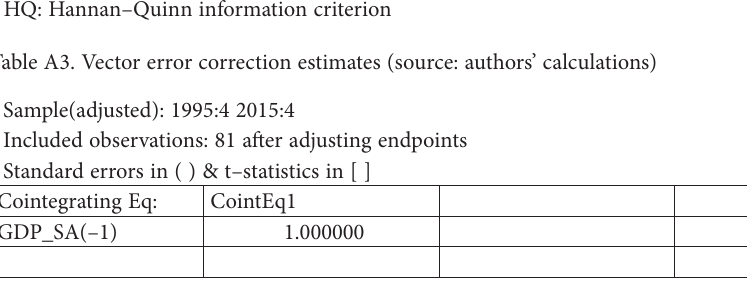
Table A3. Vector error correction estimates (source: authors’